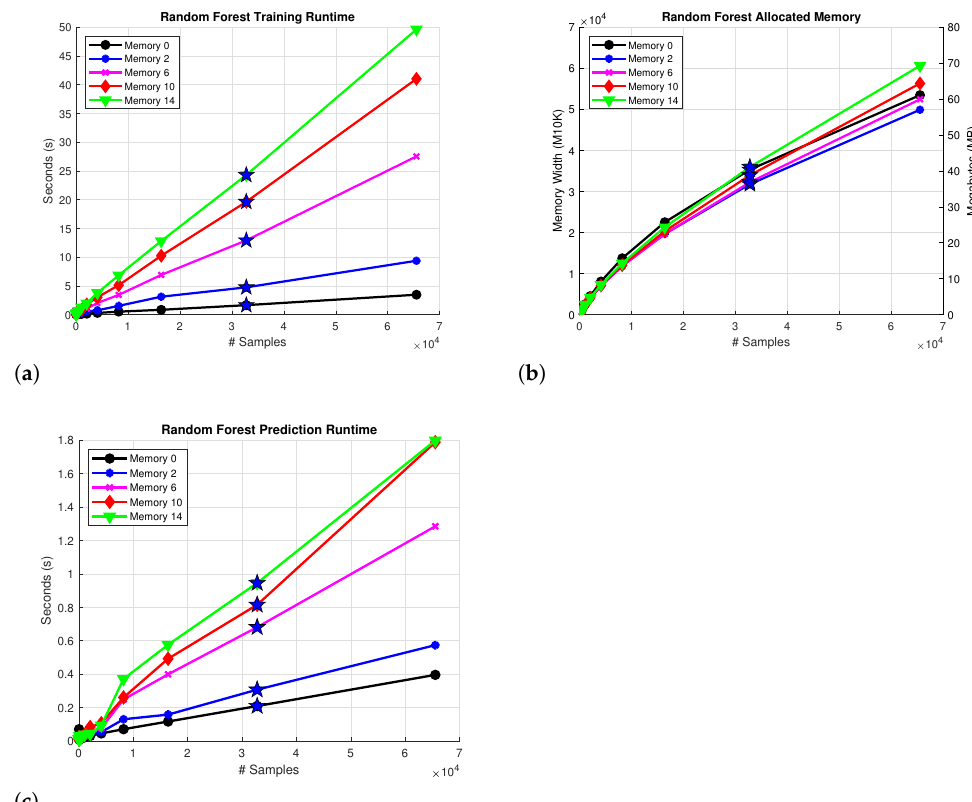
Figure 5. Complexity for the; ( a ) Construction process of a RF and ( b ) Allocated memory of the RF model ( c ) Prediction runtime of the model. The star denotes the Case 2 approximation